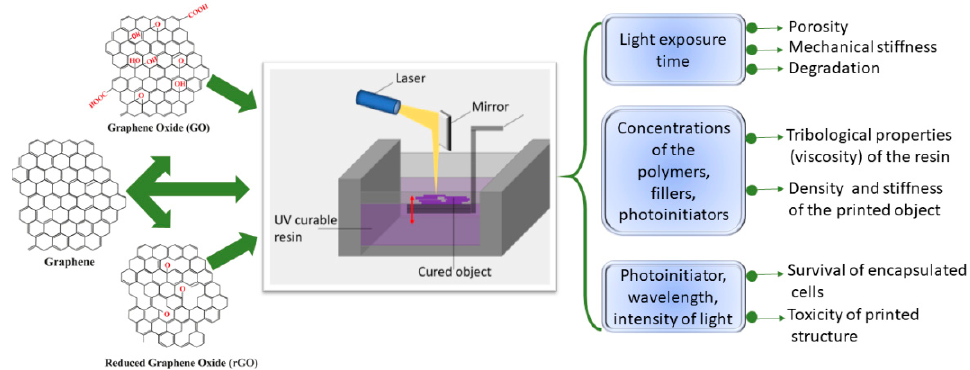
Figure 5. Overview of graphene-based resins for SLA.